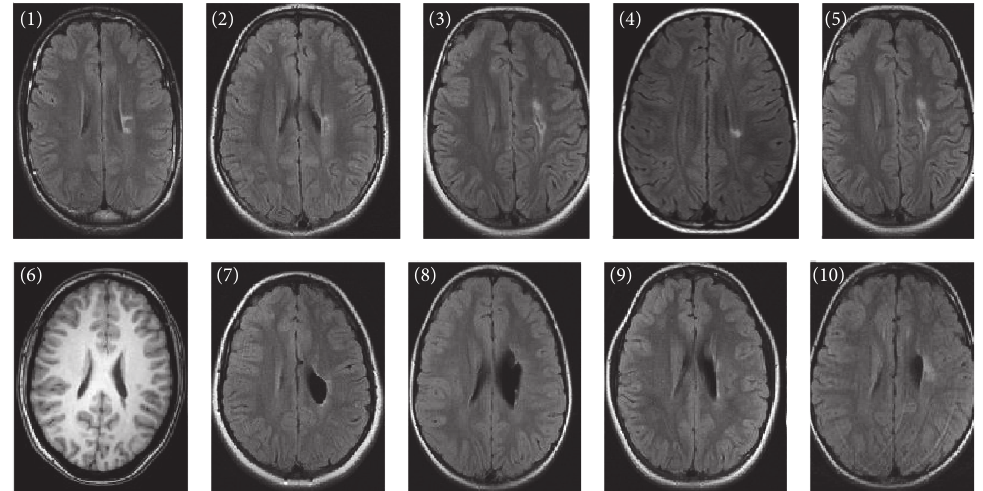
Figure 1: Anatomical fluid attenuated inversion recovery sequence images (patient (6) with T1 weighted image) for each of the patients with periventricular venous infarction according to patient number in Table 1. The single axial slices display maximum lesion volume. The individual injury patterns are detailed in Table 1.